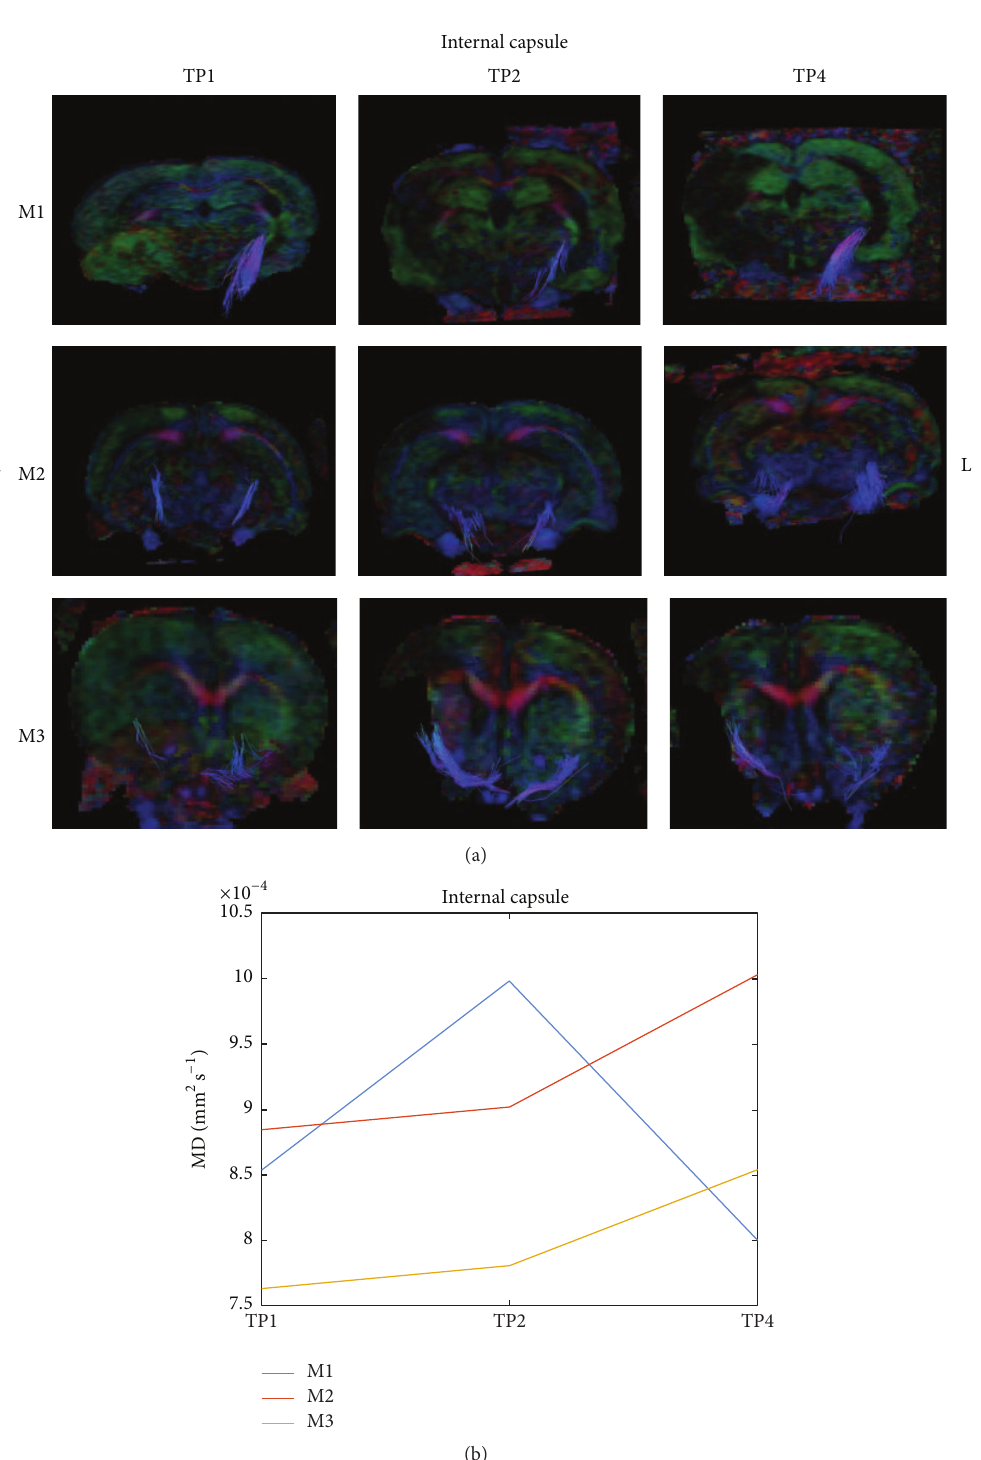
Figure 8: DTI of internal capsule. A reconstruction of the internal capsule white matter system (a) of the 3 examined rat groups (M1, M2, and M3 as described in Figure 4) at 3 time points (TP1, TP2, and TP4 as described in Figure 4). The median diffusivity of the fiber system was extracted and is shown in